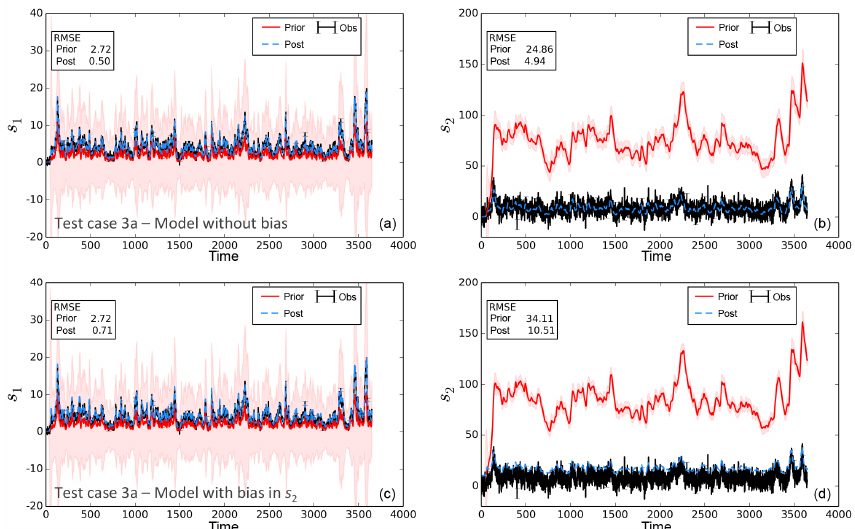
Figure 1. Prior and posterior model simulations compared to the synthetic observations for the simple carbon model for test case 3a for (a) s 1 and (b) s 2 simulations without any model bias, and (c, d) with bias in the simulated s 2 variable. The coloured error band on the prior and posterior represents the propagated parameter uncertainty (1 σ ) on the model state variables (in the equivalent colour as the mean curve). This is mostly visible for the prior model simulation (pink band) as there is a high reduction in model uncertainty reduction as a result of the